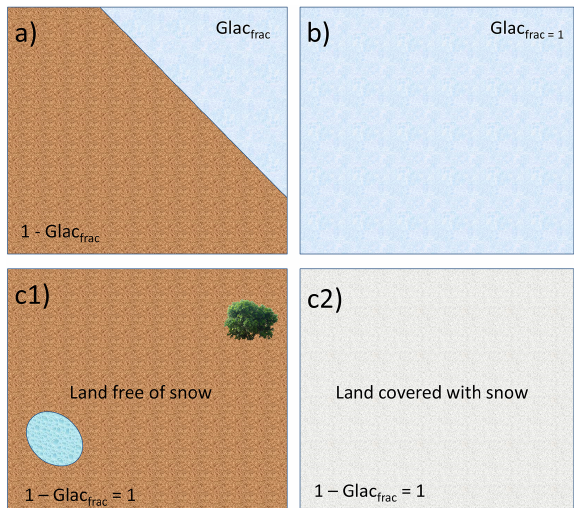
Figure 1. Illustration of SPHY sub-grid variability. A grid cell in SPHY can be (a) partially covered with glaciers, or (b) completely covered with glaciers, or (c1) free of snow, or (c2) completely cov- ered with snow. In the case of (c1) , the free land surface can consist of bare soil, vegetation, or open